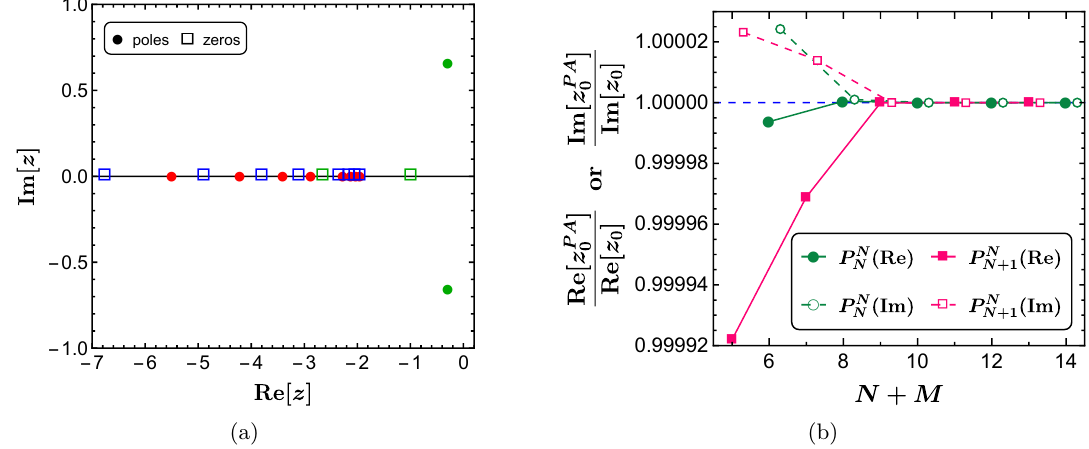
Figure 1 . (a) Poles (filled circles) and zeros (empty squares) of P 14 ( z ) built to the Taylor series of 15 g ( z ) defined in eq. (3.1). The poles and zeros that can be identified with genuine poles of g ( z ) are shown in green, while artifacts are shown in red (poles) and blue (zeros). (b) Real and imaginary parts of the complex poles z PA (normalized to their true values) for the sequences P N ( z ) and 0 N P N ( z ) , as a function of the number of parameters of the PA. To avoid inaccurate numerical results N +1 for the higher-order PAs (see appendix B), the results in this figure were obtained working with 30 decimal